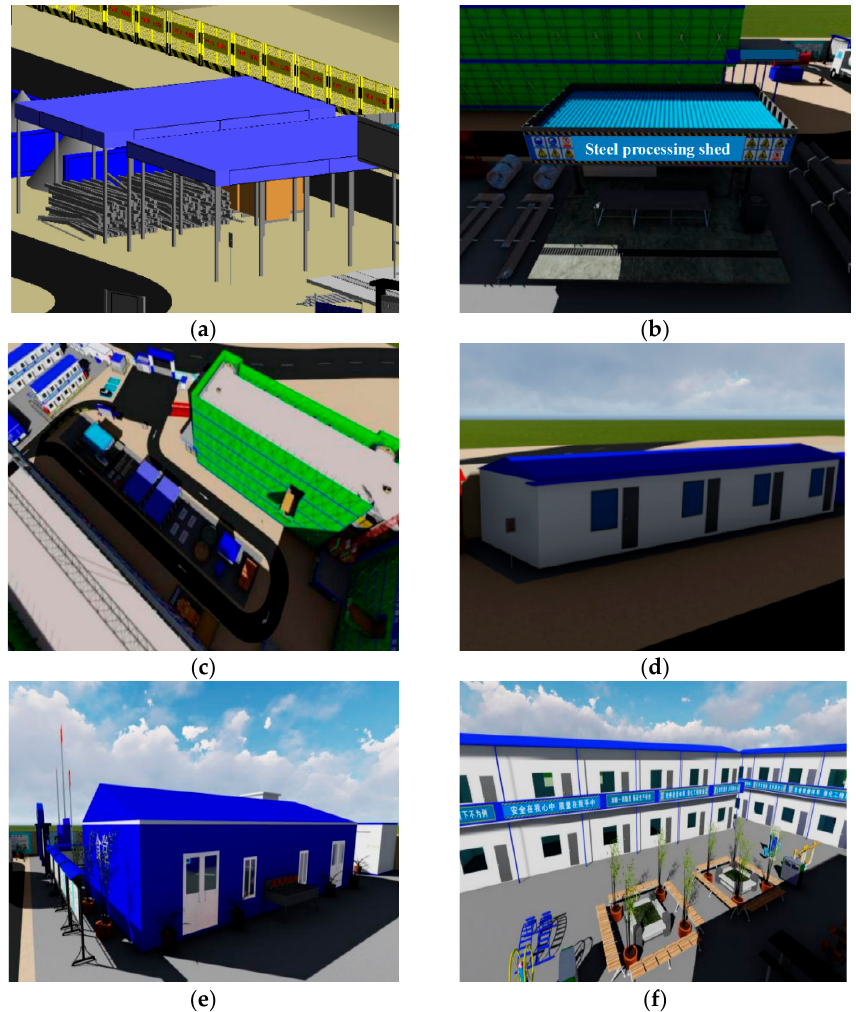
Figure 13. Visualized on-site information at different places. ( a ) Woodworking shed. ( b ) Steel bar processing shed. ( c ) Construction area. ( d ) Flammable material storage room. ( e ) Canteen. ( f ) Dormitory.